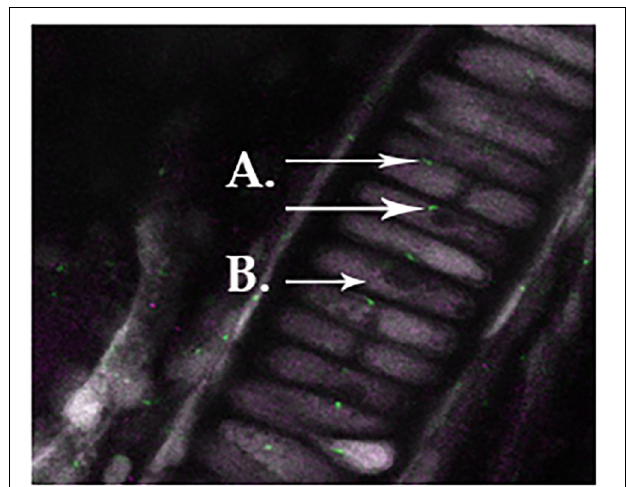
FIGURE 1 | Normal primary cilia in zebrafish chondrocytes residing in the mandible, as indicated in green staining for acetylated α -tubulin (A) . Ddr-2 is indicated by purple staining (B) , demonstrating a lack of co-localization between primary cilia and Ddr-2.